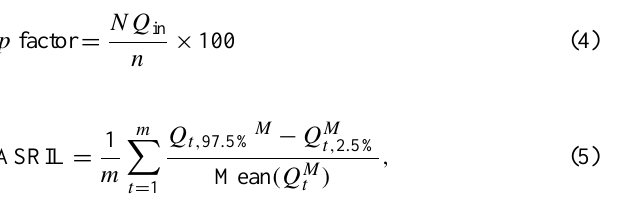
Figure 3. GLUE prediction uncertainty bounds for the Vène and the Pallas catchment. The grey shaded area is the 95% prediction uncertainty interval and the black dotted line corresponds to the ob- served